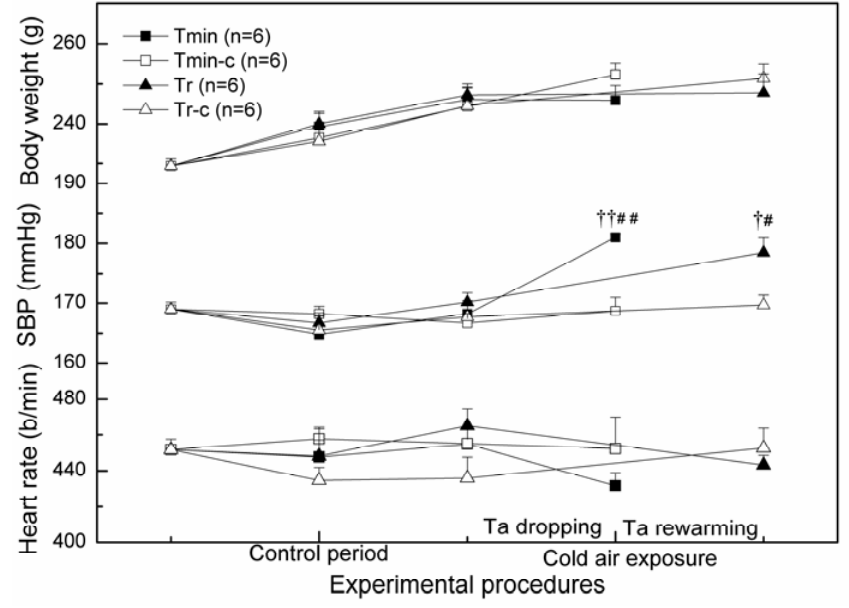
Figure 1. Variation of body weight, SBP and heart rate during control period and cold air treatment in different groups. SBP systolic blood pressure; Ta ambient